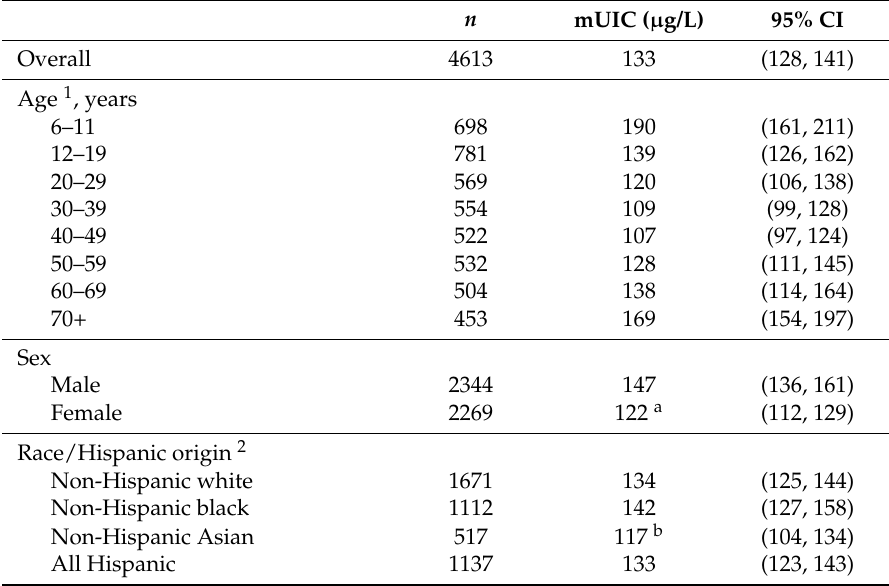
Table 1. Median UIC ( µ g/L) of U.S. Children and Adults aged 6 years and over, by demographic and lifestyle characteristics, NHANES